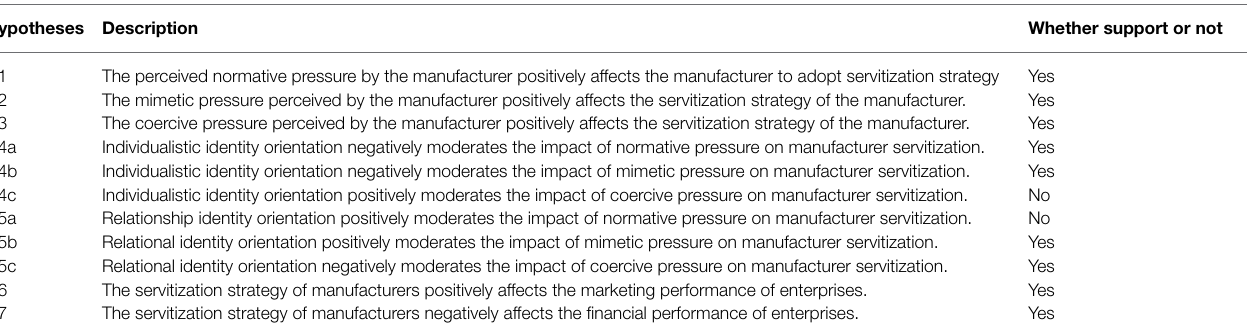
TABLE 11 | Summary of the hypotheses included in this